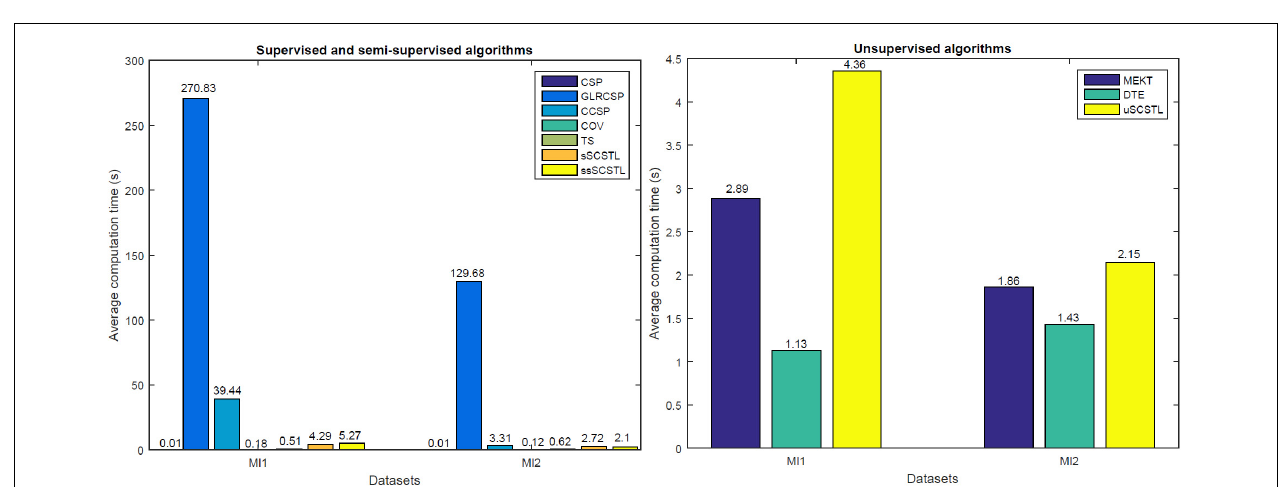
FIGURE 8 | The feature distributions of different algorithms displayed in the two-dimensional space.